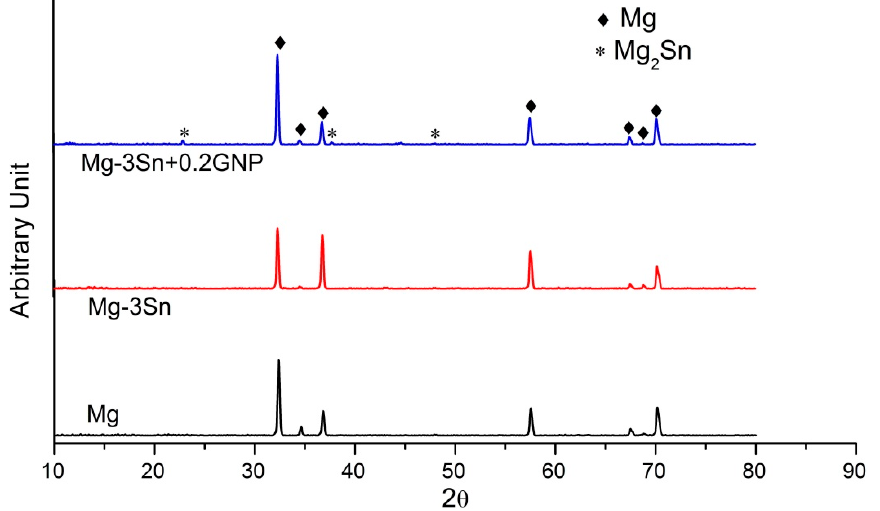
Figure 4. XRD results of extruded samples of pure Mg, Mg-3Sn alloy, and Mg-3Sn + 0.2 GNP nanocomposite.